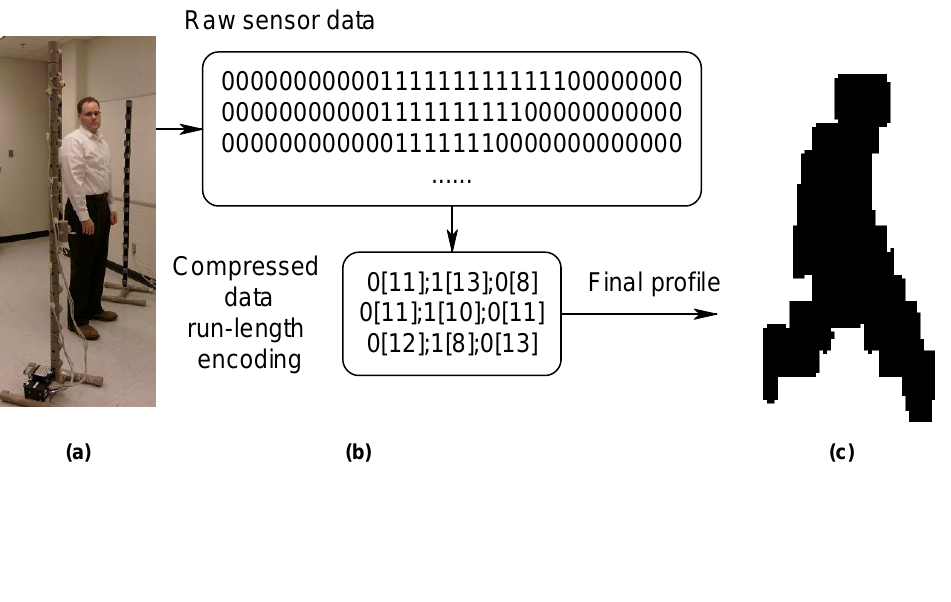
Figure 6. (a) Near-IR PFx sensor with detectors vertically deployed. (b) Output from an algorithm that formats PFx sensor data. (c) Output from an algorithm that produces a silhouette from formatted PFx